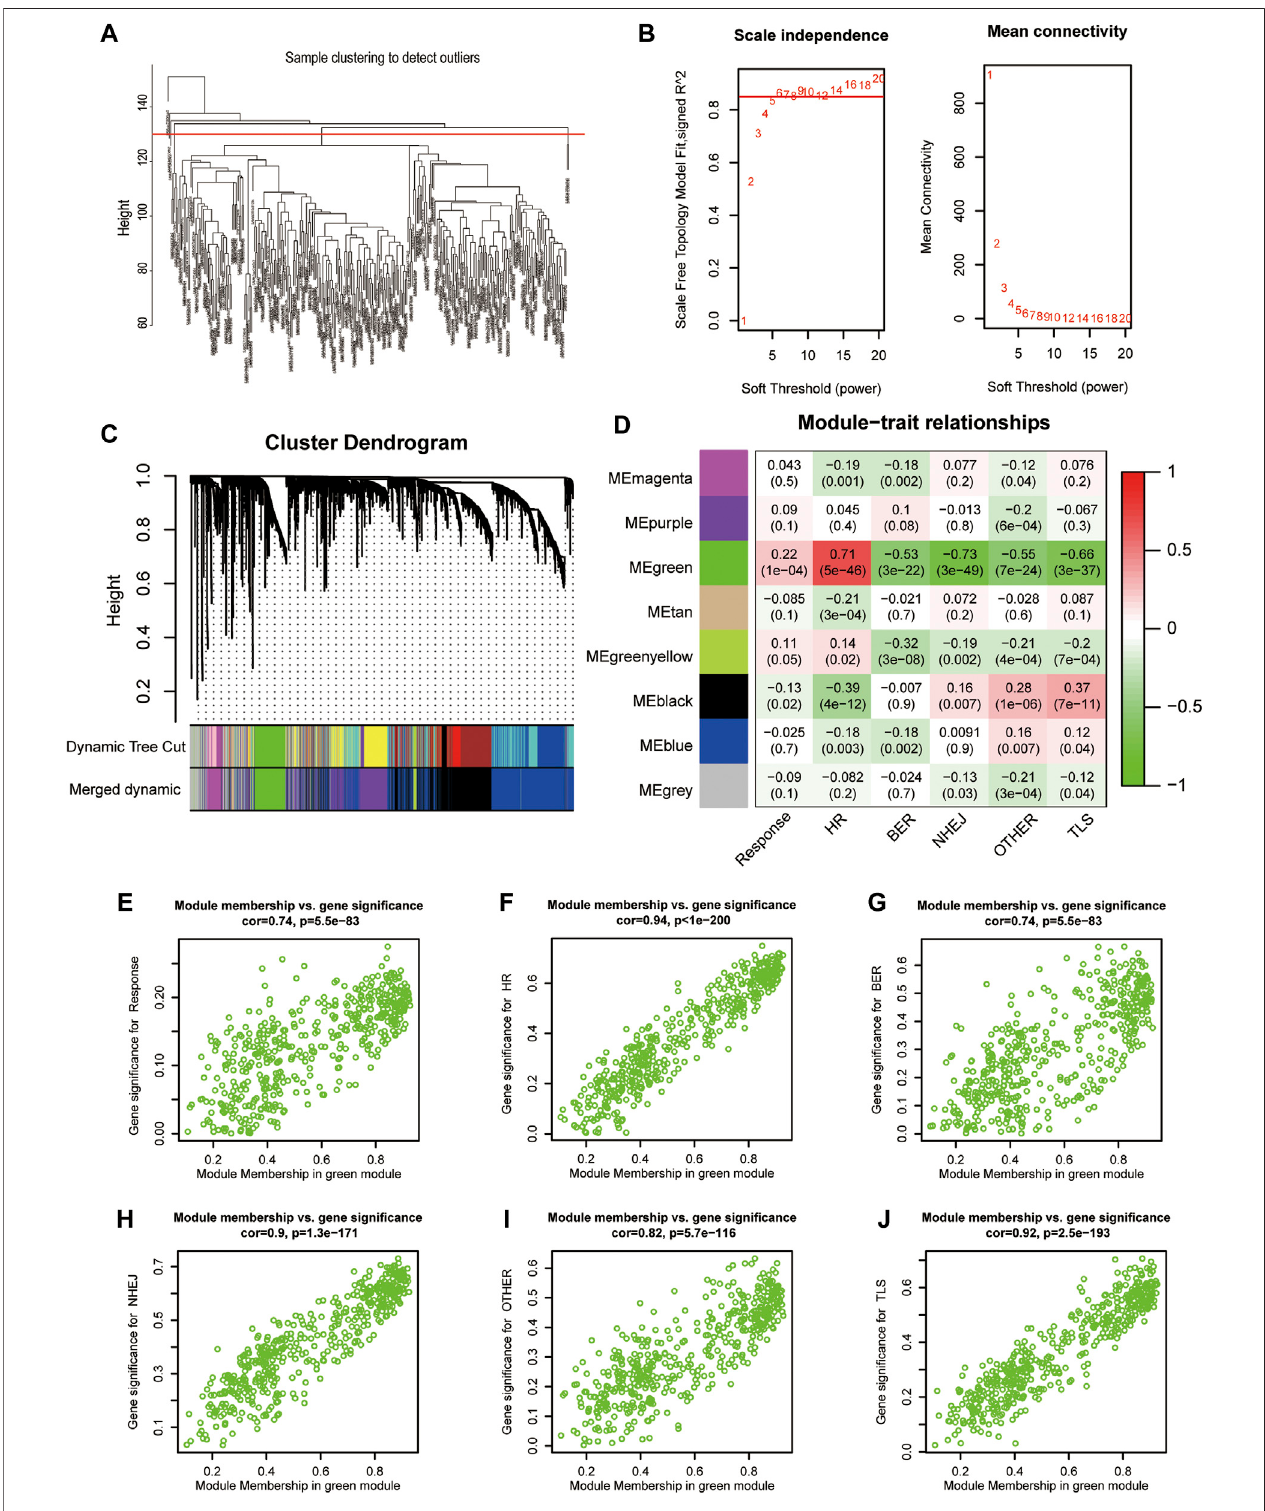
FIGURE 3 | Construction of gene weighted co-expression network. (A) , Sample cluster diagram. (B) , Analysis of the scale-free topology model fi t index for soft threshold powers ( β ). (C) , A cluster dendrogram was built based on the dissimilarity of the topological overlap, which presents different gene co-expression modules in IMvigor210, modules with a clustering degree less than 0.25 were merged. (D) , Heatmap analysis of the correlation between module eigengenes of IMvigor210 and enrichmentscoreofDNAdamagerepairpathway. (E – J) ,ThescatterplotofGSfortheresponse,differentenrichmentscoreofDNAdamagerepairpathwayvs.MM in the green module. FA/HR, Fanconi Anemia/homologous recombination; BER, base excision repair; NHEJ, non-homologous end joining; OTHER, other; TLS, translesion synthesis; GS, gene signi fi cance; MM, module membership.